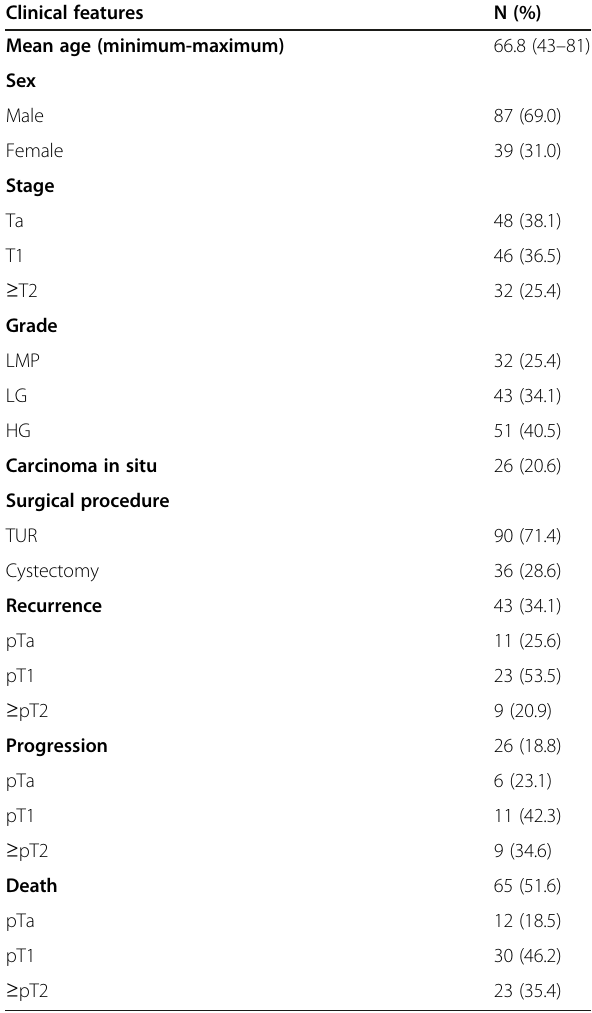
Table 1 Clinicopathologic characteristics of 126 patients with bladder cancer ð